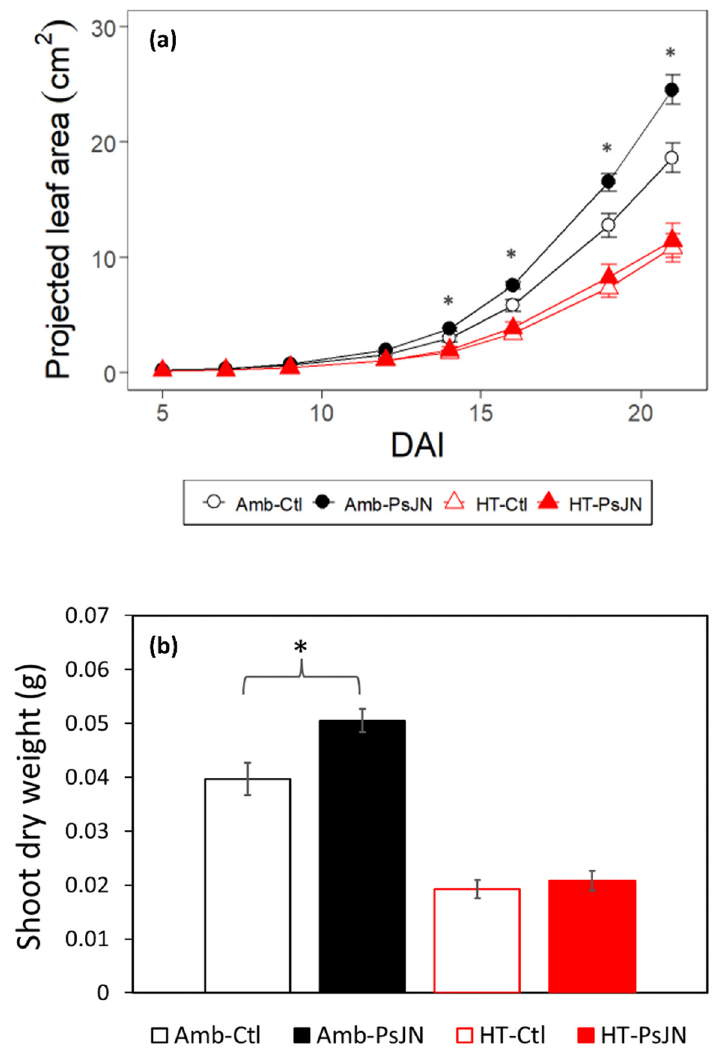
Figure 6. Projected leaf area and dry weight. ( a ) Measured projected leaf area of Arabidopsis ro- settes growing outside of the agar-filled plates with or without bacteria PsJN inoculation under am- bient or high temperature conditions. Temperature—black and circle symbol (ambient tempera- ture), red and triangle symbol (high temperature); bacterial application—empty symbol (control), filled symbol (PsJN-inoculated). ( b ) Dry weights of shoots from all treatments during invasive har- vest. Treatments: Amb-Ctl (control plants under ambient temperature), Amb-PsJN (PsJN-inoculated plants under ambient temperature), HT-Ctl (control plants under high temperature), and HT-PsJN (PsJN-inoculated plants under high temperature). All of the points are the mean ± standard error of n = 12 (Amb-Ctl), 15 (Amb-PsJN), 12 (HT-Ctl), 8 (HT-PsJN) samples within each treatment. Asterisks: Black—significant difference between mean of PsJN-inoculated and control plants under ambient condition; these are based on the Student’s t -test with p < 0.05. 3. Discussion Our studies utilizing both the conventional closed-plate and a new open-top systems demonstrated the growth stimulatory effects of the P. phytofirmans PsJN bacteria on the roots and shoots of the Arabidopsis plants at the ambient and high-temperature condi- tions. The morphological responses and growth dynamics of the roots and shoots were resolved by monitoring their development through non-destructive phenotyping which was combined with destructive harvesting. Here, we discuss the changes in the root sys- tem architecture of Arabidopsis in light of the known regulatory events by intrinsic factors such as hormones, as well as external biotic and abiotic environmental stimuli. Then, we